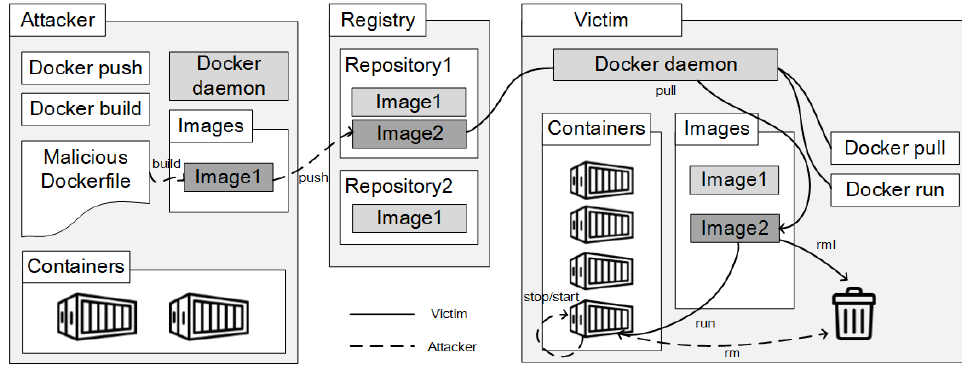
Figure 16. Overall attack and victim workflow.